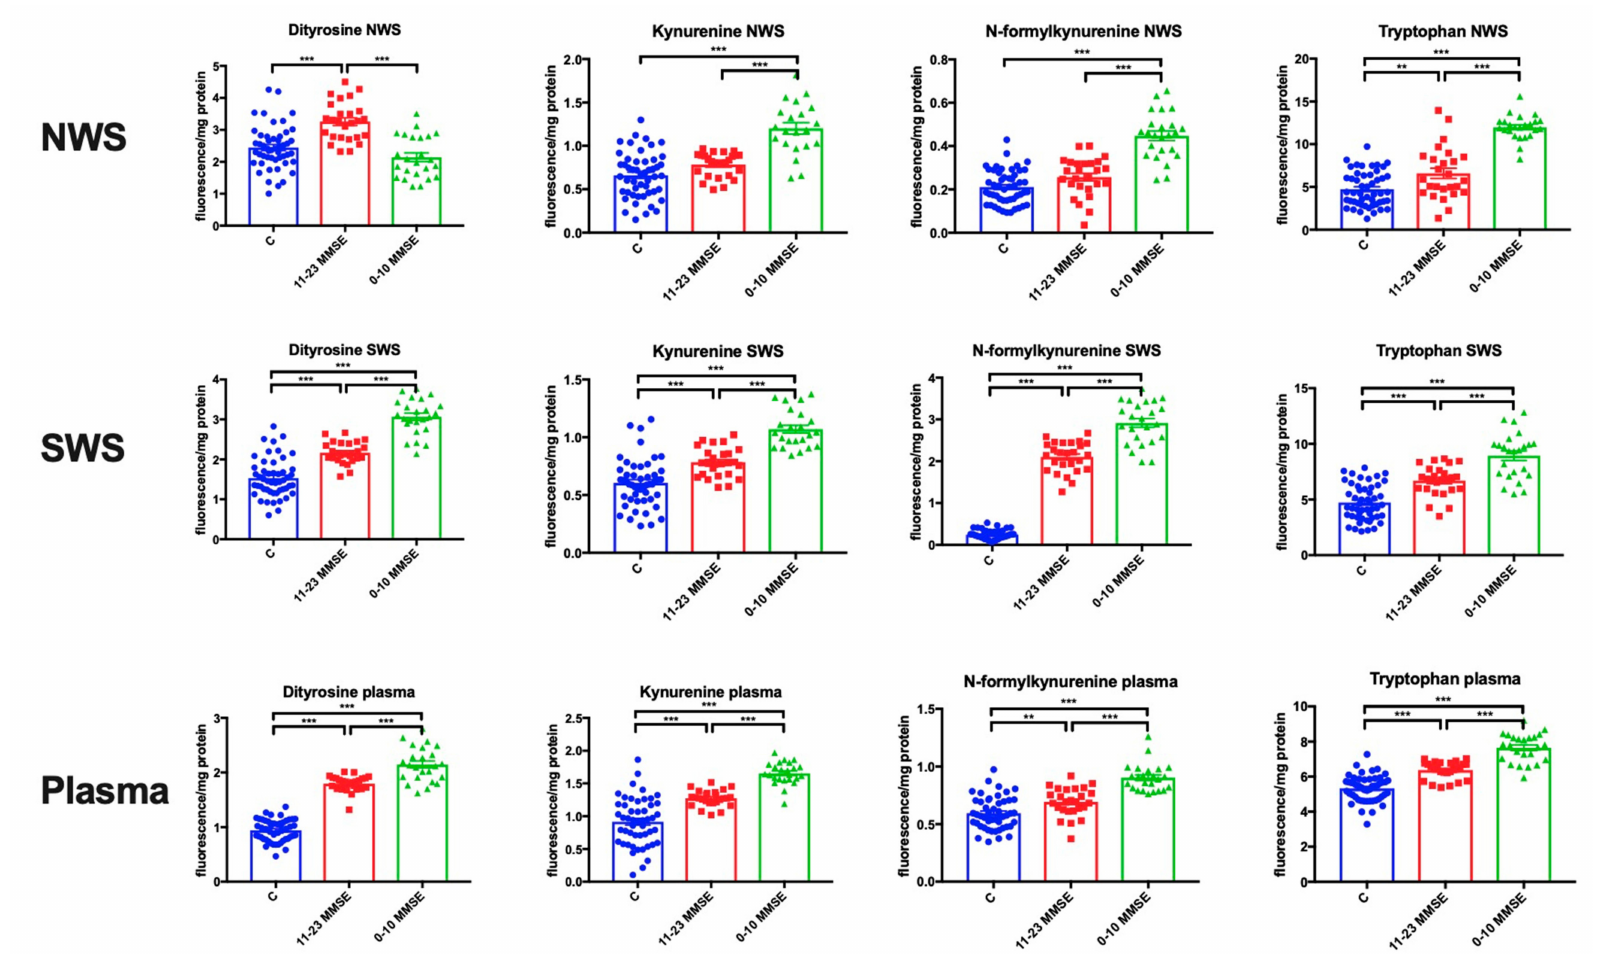
Figure 3. Protein glycoxidation in non-stimulated and stimulated saliva as well as plasma of patients in di ff erent stages of dementia, and healthy controls. Abbreviations: C—the control; MMSE—Mini Mental State Examination; NWS—non-stimulated whole saliva; SWS—stimulated whole saliva. ** < 0.01, *** <